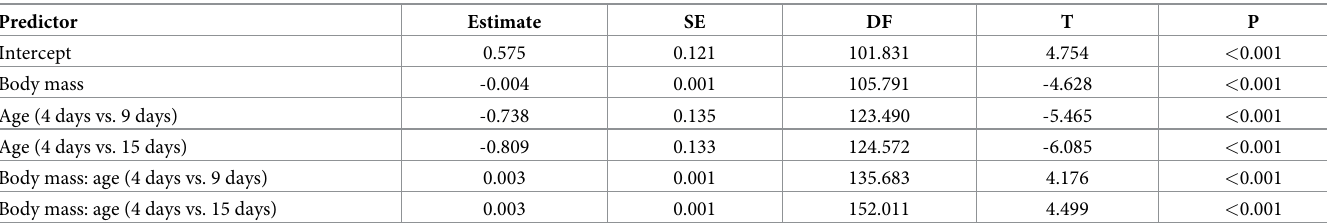
Table 2. Parameter estimates for minimal adequate models on the heterophil vs. lymphocyte (H/L) ratio (n wild = 24, n farmed = 40). Predictor